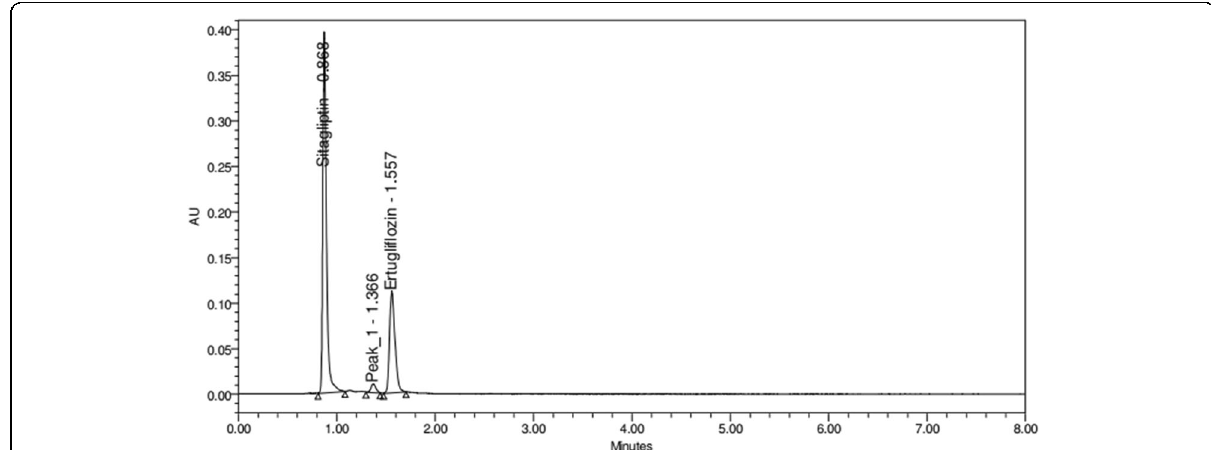
Fig. 7 Chromatogram of acid degradation